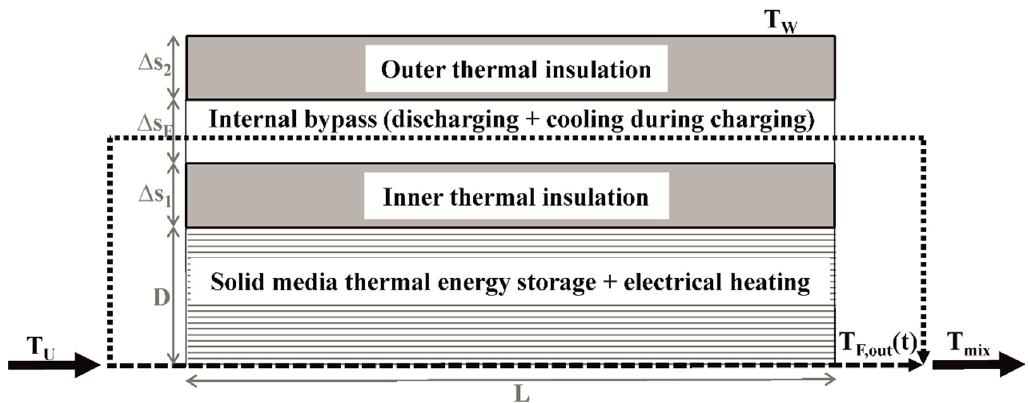
Figure 3. Alternative concept—electrical heated solid media thermal energy storage with internal bypass for discharging and charging operation ( D/L —storage medium diameter/length; ∆ s 1 / ∆ s 2 — inner/outer thermal insulation thickness; ∆ s F —fluid gap).